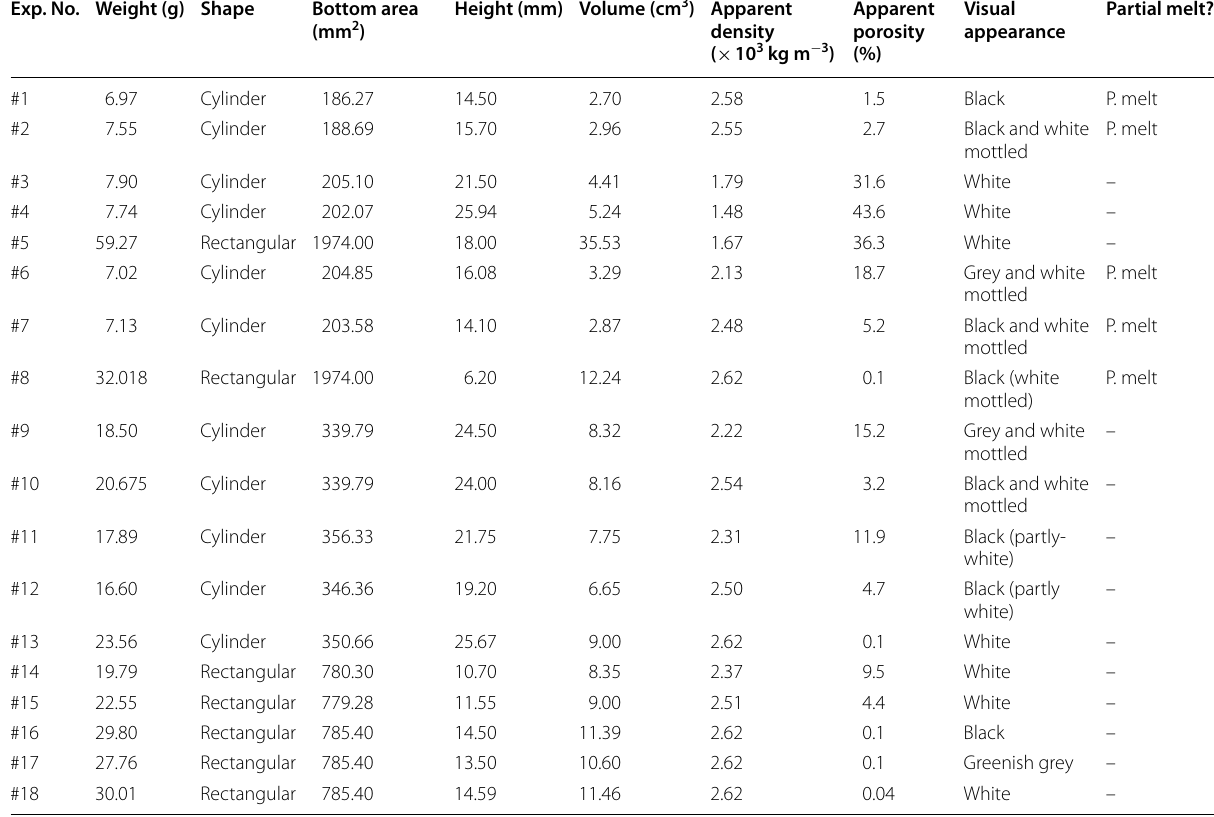
Table 2 Summary of the results of hot pressing